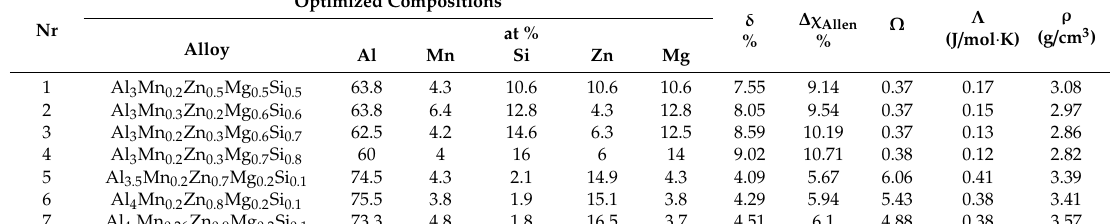
Table 3. Multiobjective optimization results for Al-Mn-Zn-Mg-Si system.